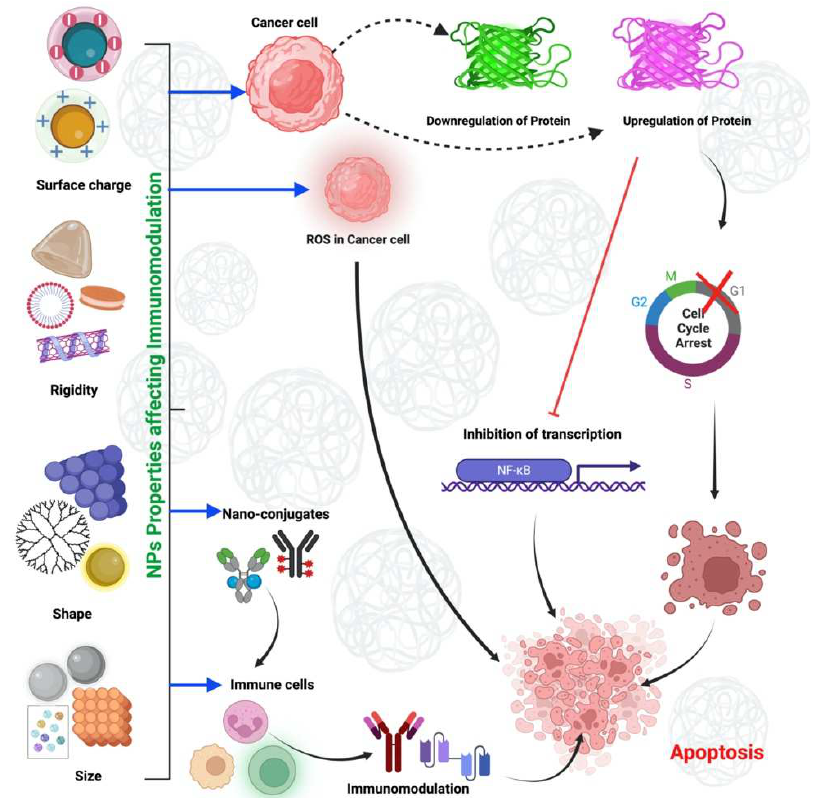
Figure 3. Physicochemical properties of nanomaterials and mechanisms of cell death in cancer induced by nanoparticles.